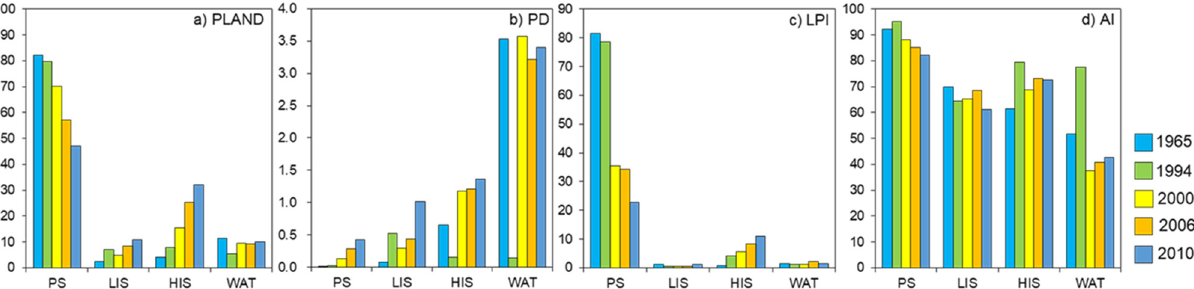
Figure 5. The landscape metrics of different impervious and non-impervious surfaces in Shanghai (1965–2010). PS = pervious surfaces, LIS = low impervious surfaces, HIS = high impervious surfaces, WAT = water. ( a ) The PLAND of PS was decreasing year by year. The PLAND of LIS and HIS were increasing year by year and the PLAND of HIS had the fastest rising speed, up to 70%, WAT kept stable; ( b ) The PD of PS, LIS and HIS were increasing year by year, WAT kept stable; ( c ) The LPI of PS decreased obviously from 82 to 23 and the LPI of HIS increased year by year, reaching 11.04 in 2010; ( d ) The AI of PS and LIS decreased from 92 to 82 and from 70 to 61 and The AI of HIS and WAT kept